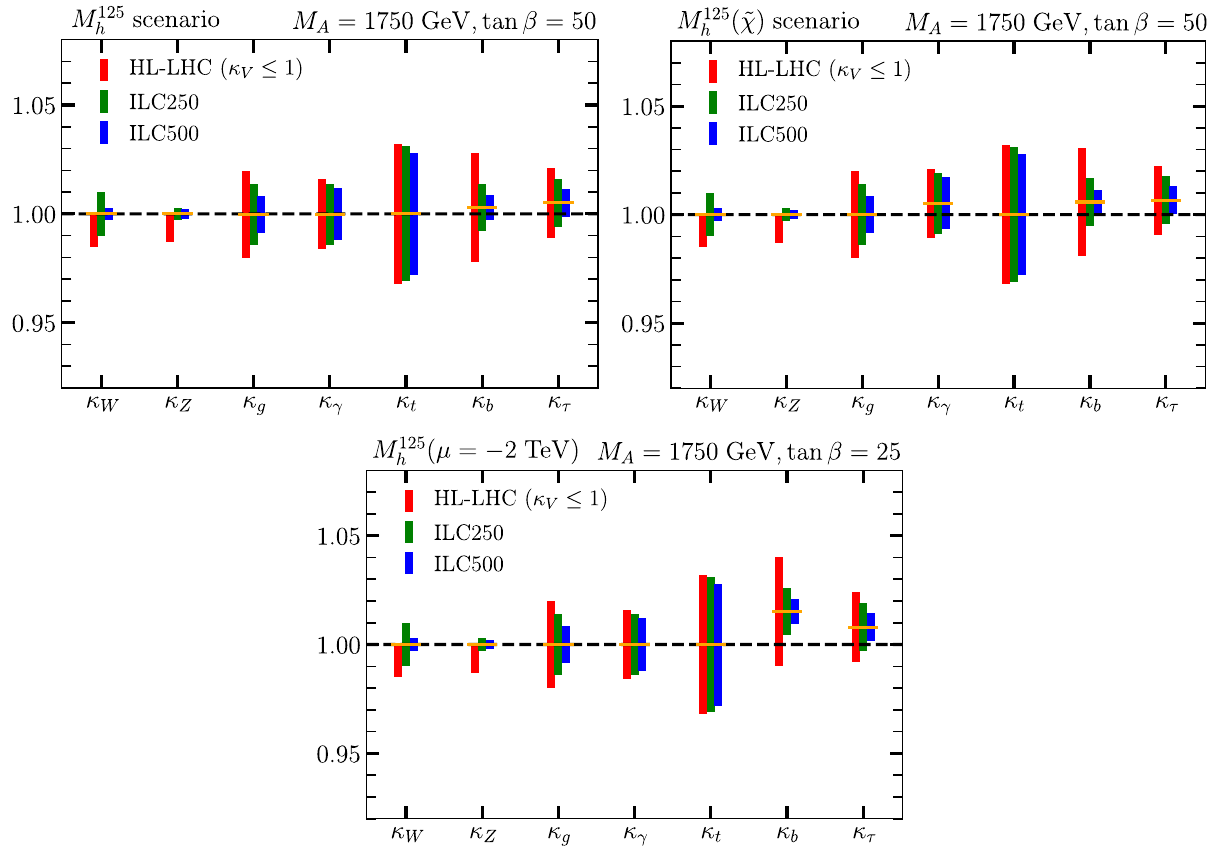
Fig. 15 Wäscheleinen-plots , using the same color coding as in Fig.9, for the following three assumed MSSM scenarios: ( M A , tan β) = ( 1750GeV , 50 ) in the M 125 scenario (upper left panel), ( M A , tan β) = h ( 1750GeV , 50 ) in the M 125 ( ˜ χ) scenario (upper right), and h ( M , tan β) = ( 1750GeV , 25 ) in the M 125 ,μ − scenario (lower A h